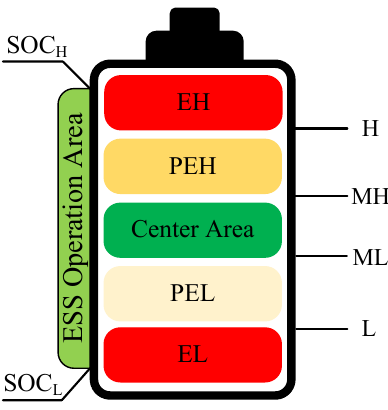
Figure 4. SOC sections for management strategy.